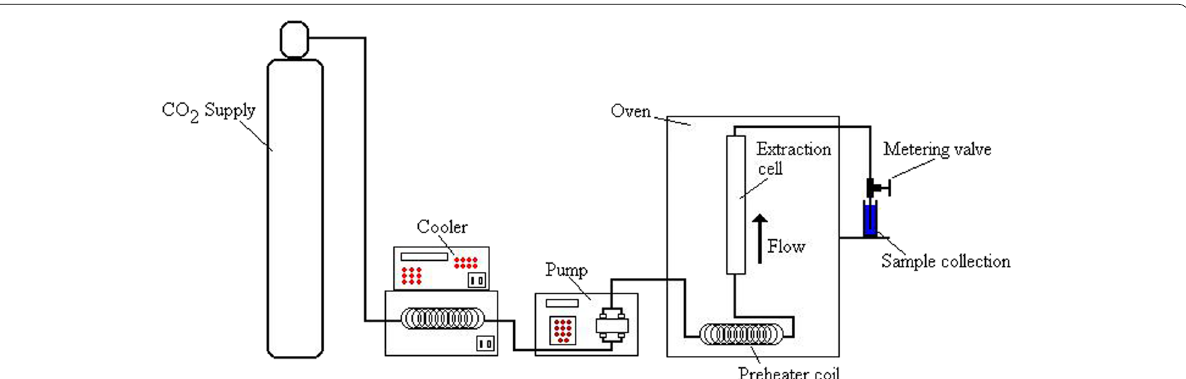
Fig. 6 Diagram of a supercritical fluid extraction (Adopted from Wikiwand.com URL: https:// www. wikiw and. com/ en/ Super criti cal_ fluid_ extra